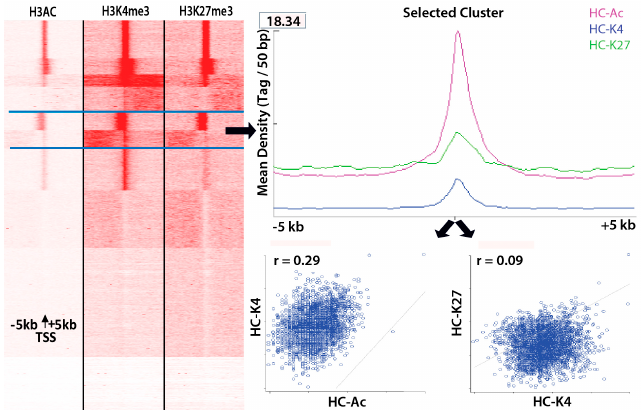
Figure A2. Genome wide differential histone marks in H3Ac, H3K4me3, and H3K27me3 modifications. Read density in ±5 kb of any known transcriptional start site for each marker are clustered and visualized in a heat map that consists of three panels in the order of Ac, K27, and K4 (from left to right). A selected cluster with differential density profile centralized at the transcription start sites are marked under the blue lines, which shows a slight correlation (Pearson coefficient, r = 0.29) between K4 and Ac modifications while no correlation (Pearson coefficient, r = 0.09) is observed between K4 and K27 modifications due to maternal high fat( HF) diet. HC, HF-diet exposed treatment.